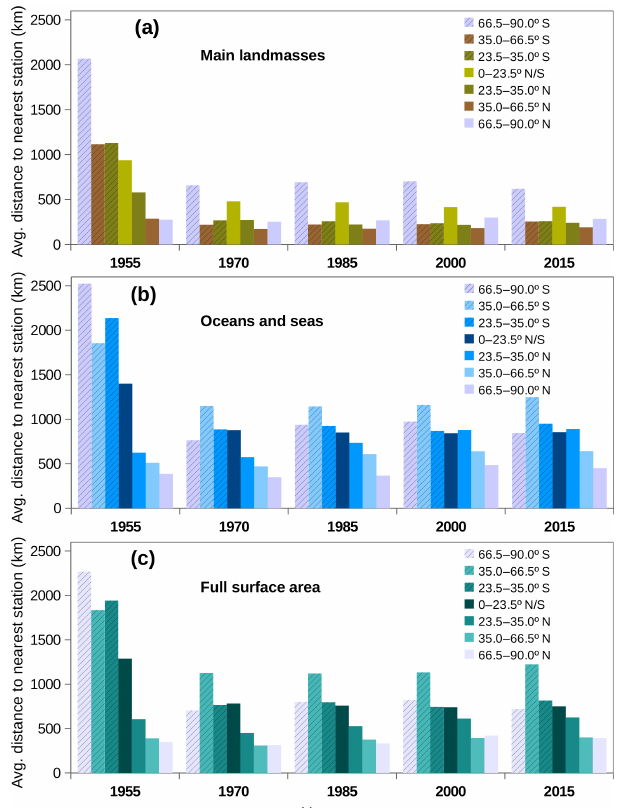
Figure 5. Average distance to the nearest station, among the humidity-reporting stations from 1955 to 2015 in 15-year intervals, as calculated in specific areas of each latitude zone (see insets): (a) main landmasses; (b) oceans and seas; (c) full surface area. See text for calculation details (Sect. 2.3.1).